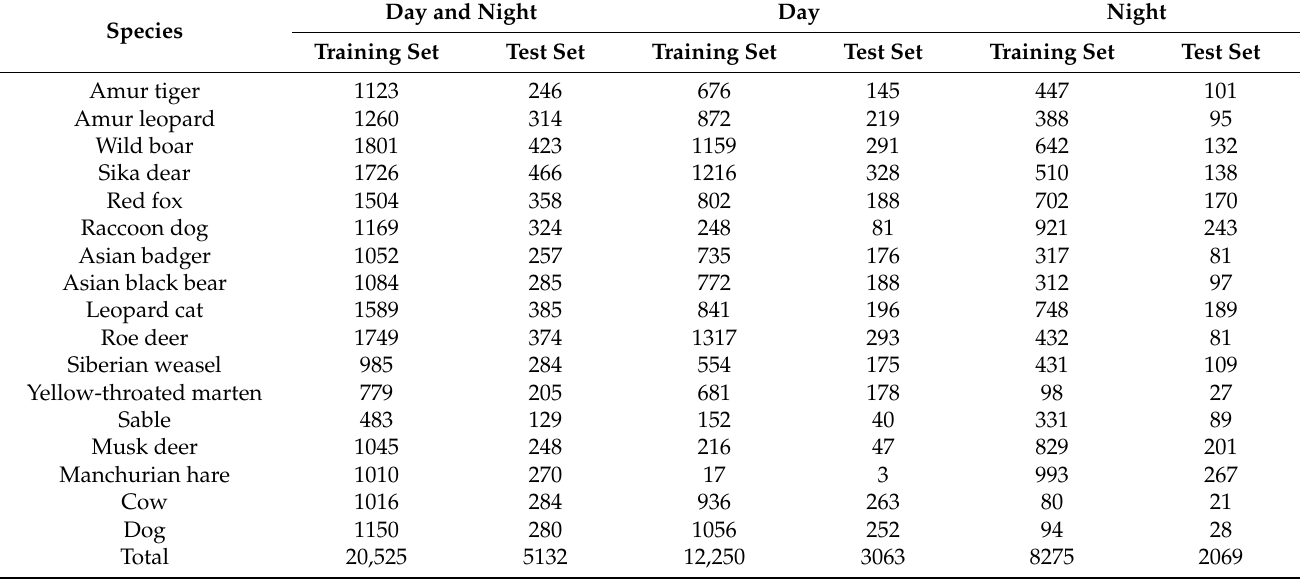
Table 3. NTLNP dataset and per-class training set and test set